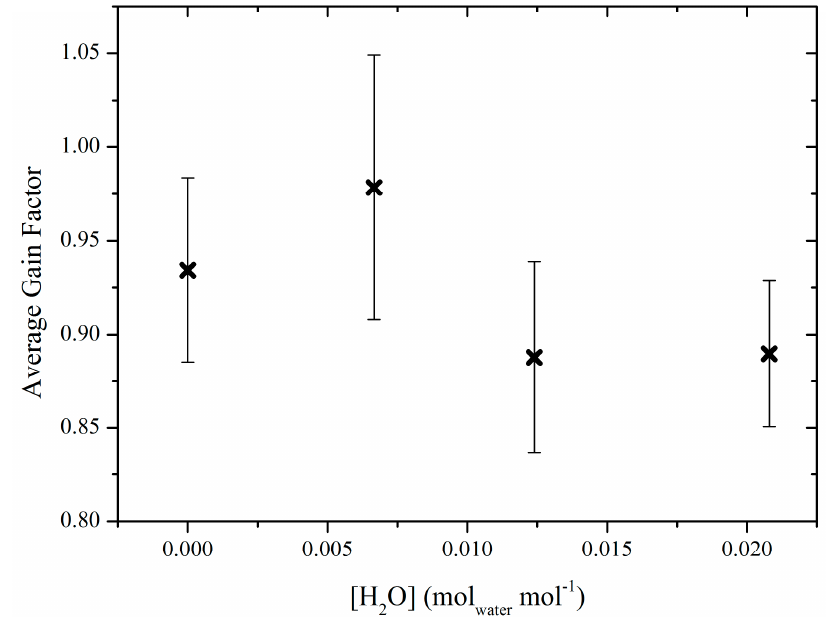
Figure 4. M as a function of [H 2 O] (crosses) and associated uncertainties (shown as error bars), representing one standard deviation.